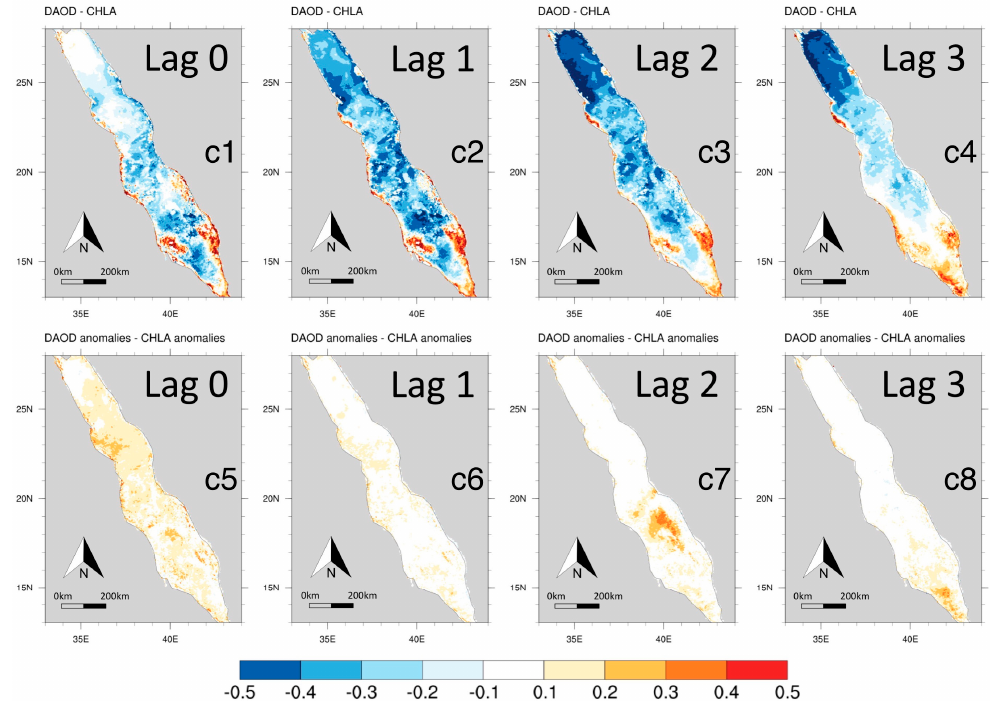
Figure 7. Cross Correlation maps of actual observations and anomalies for SST ( a1 – a8 ), WINDSPEED ( b1 – b8 ) and DAOD ( c1 – c8 ) (MERRA-2 Dust Scattering AOT in 550 nm), with Chl- a for a time lag of 0 month (first column), lag of one month (second column), lag of two months (third column), and lag of three months (fourth column).